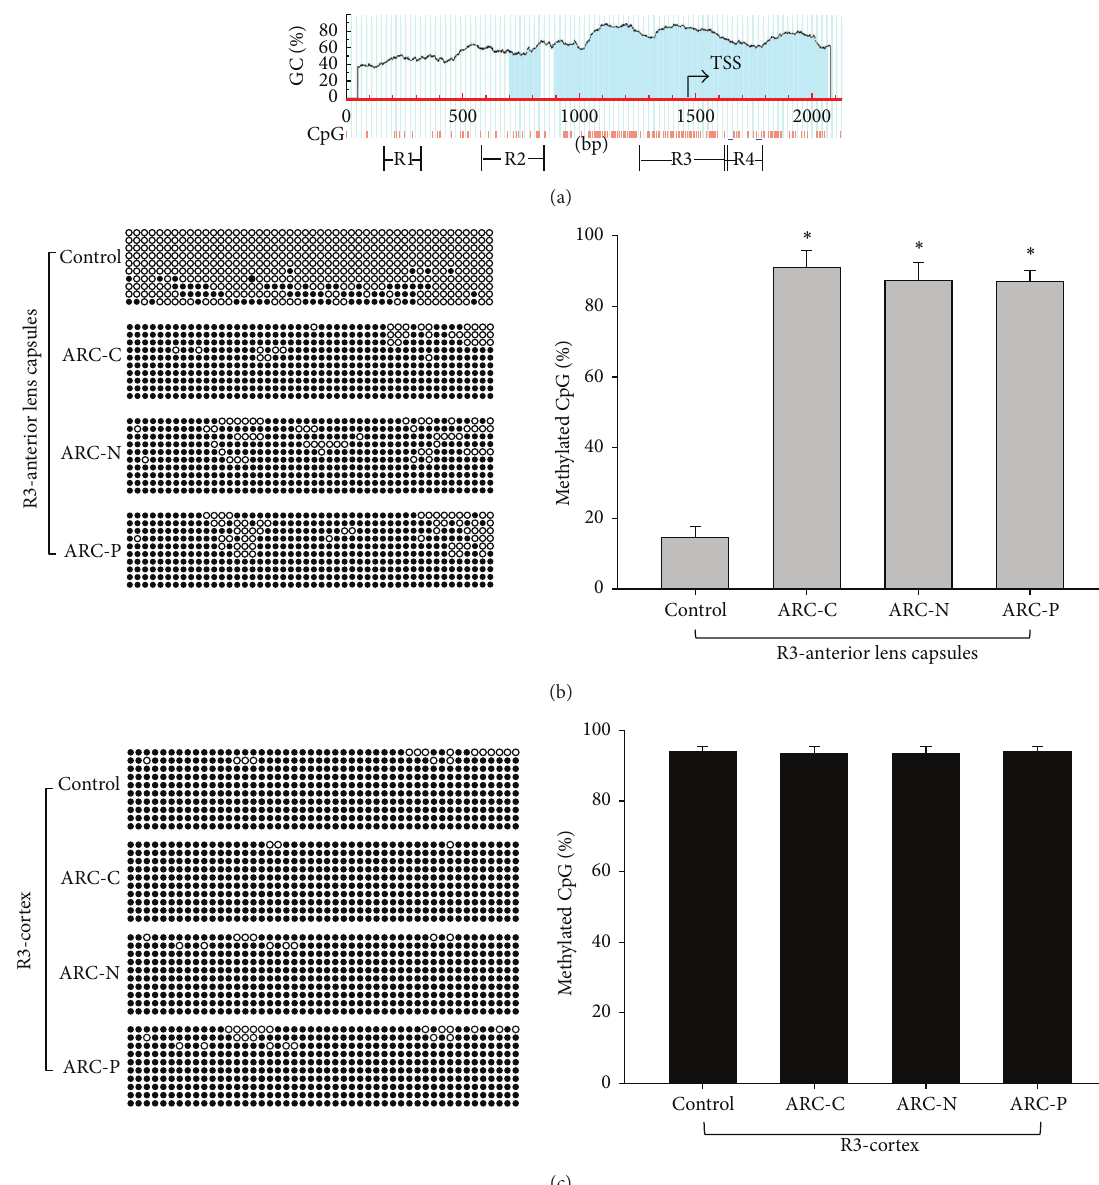
Figure 2: Methylation status at region 3 in WRN promoter in anterior lens capsules and cortex of control and ARC. (a) The positions of CpG islands within WRN promoter. In the following panels, each row of circles represents a single clone. Open and close circles represent unmethylated and methylated CpG sites, respectively. (b) Methylation status of region 3 in WRN promoter in anterior lens capsules of control ( 𝑛 = 20 ) and ARC-C ( 𝑛 = 20 ), ARC-N ( 𝑛 = 20 ), and ARC-P ( 𝑛 = 20 ). The ARC group displayed hypermethylation compared to the control group. ∗ 𝑃 < 0.01 . (c) Methylation status of region 3 in WRN promoter in lens cortex of control and ARC lens. There were no significant statistical differences between the ARC group and the control group. 𝑃 > 0.05